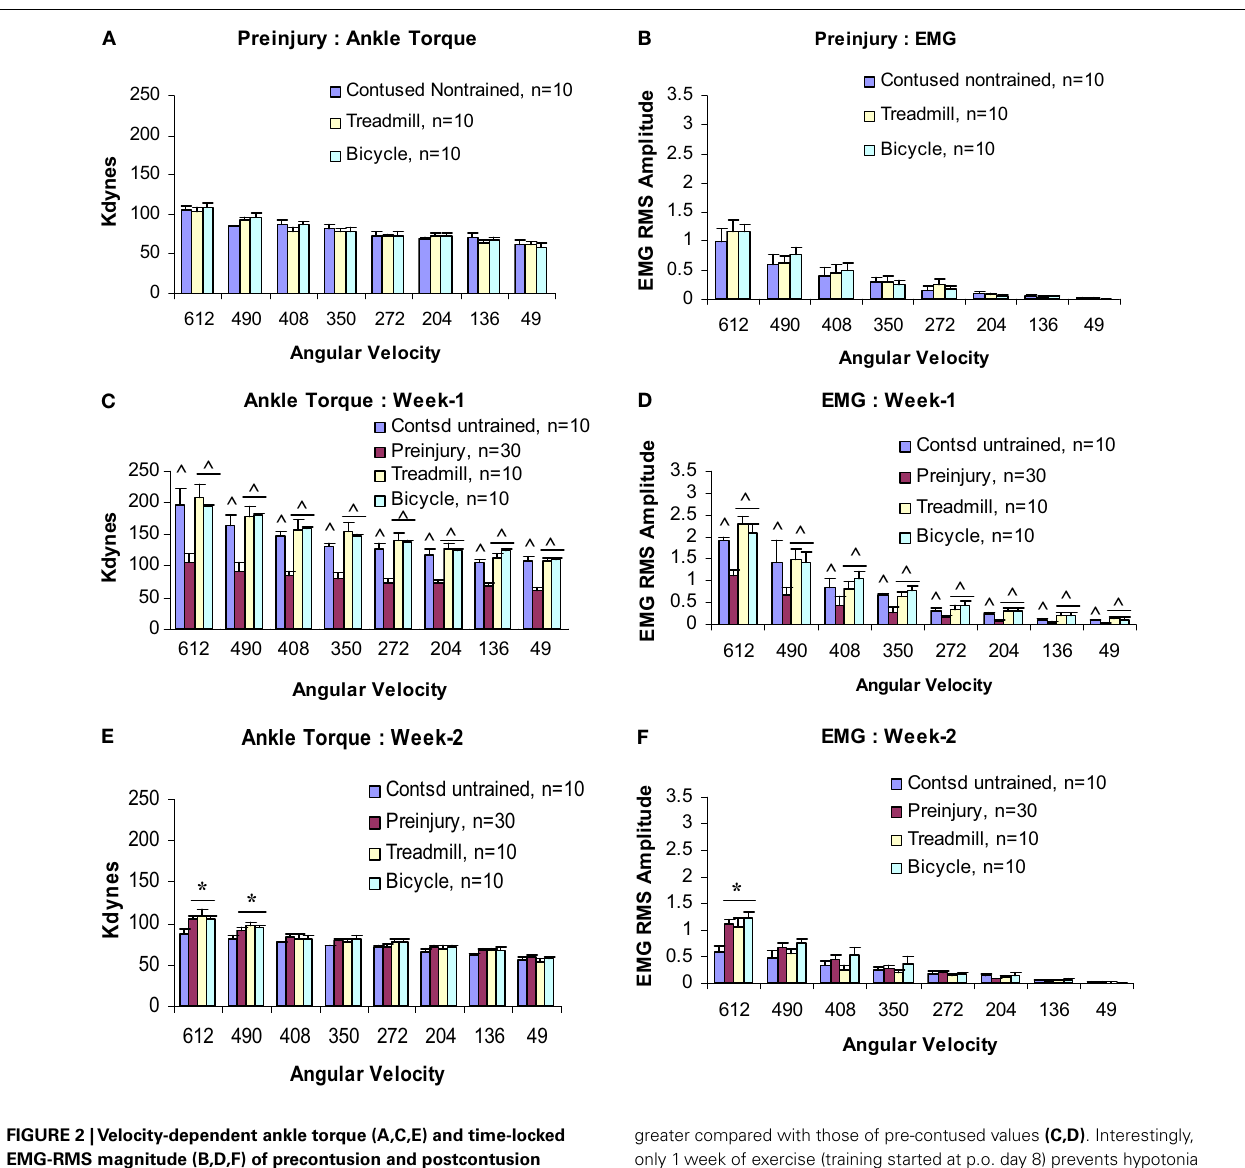
FIGURE 2 |Velocity-dependent ankle torque (A,C,E) and time-locked EMG-RMS magnitude (B,D,F) of precontusion and postcontusion weeks 1 and 2. Note, both ankle torque and EMG-RMS values of postcontusion week 1 in all eight velocities (612–49˚/s) were significantly